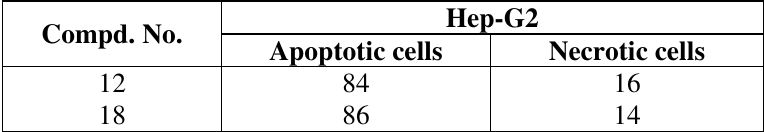
Table 2. Apoptosis and necrosis assay for cytotoxic compounds only.